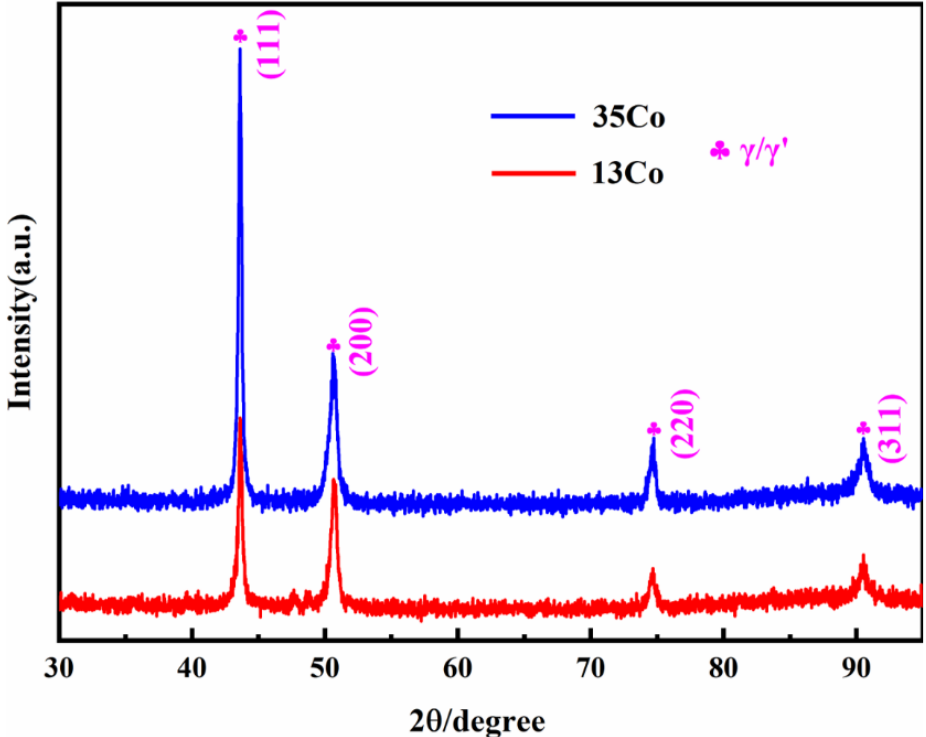
Figure 5. XRD spectra of the 13Co and 35Co alloys after heat